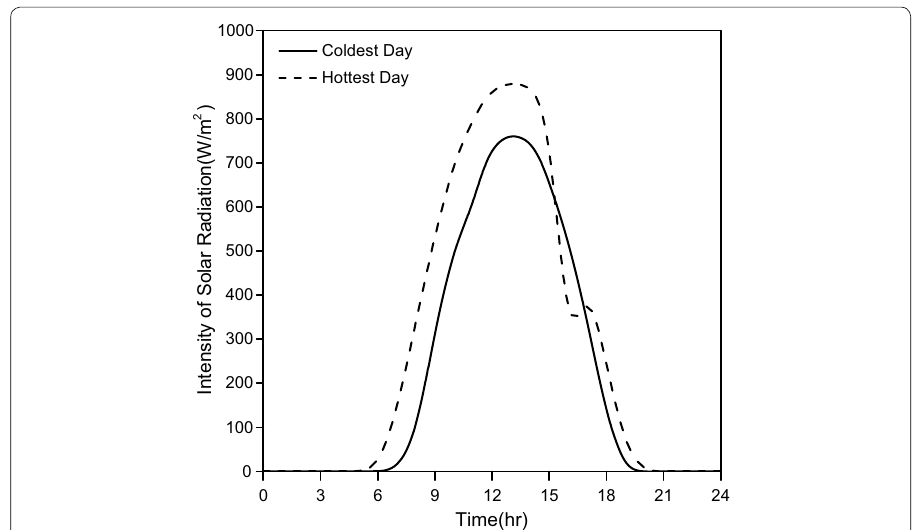
Fig. 3 Solar radiation intensity for the hottest day (21st April) and the coldest day (24th January), 2016 in Jamshedpur, India